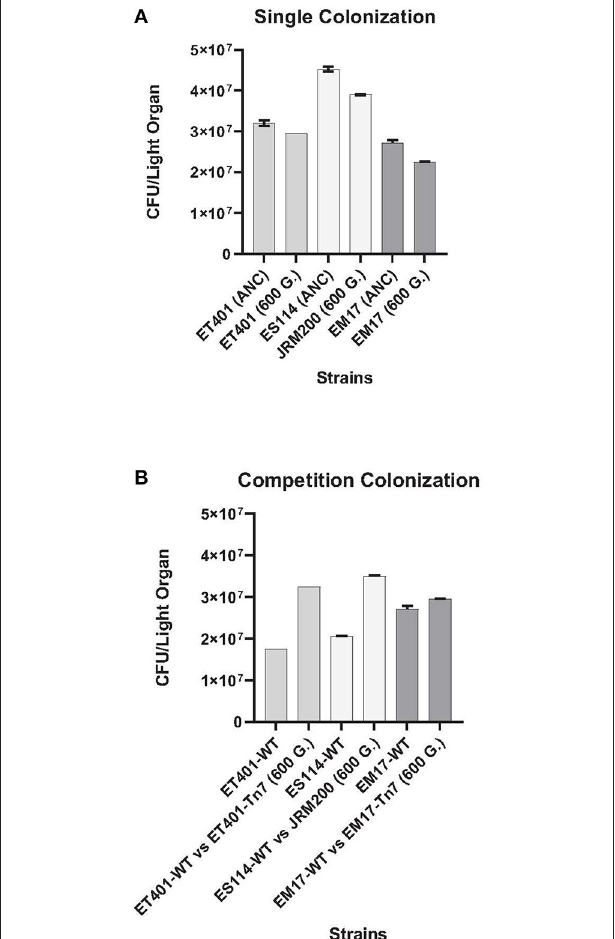
FIGURE 3 | (A) Animal colonization assays at 600 generations with single strains and competitions between ancestor and evolved (pH 7.2) strains in E. scolopes juveniles. CFU, colony forming units. See Table 1 for strain designations. (B) Animal competition assays 48-h post-infection of juvenile Euprymna scolopes between ancestor (control) and evolved strains of Vibrio fischeri at 600 generations (pH 7.2). CFU, colony forming units. See Table 1 for strain